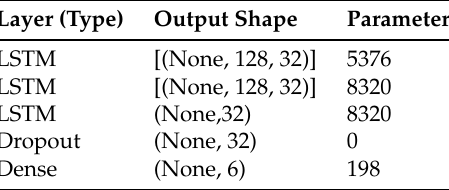
Table 7. Structure of the designed LSTM network model.